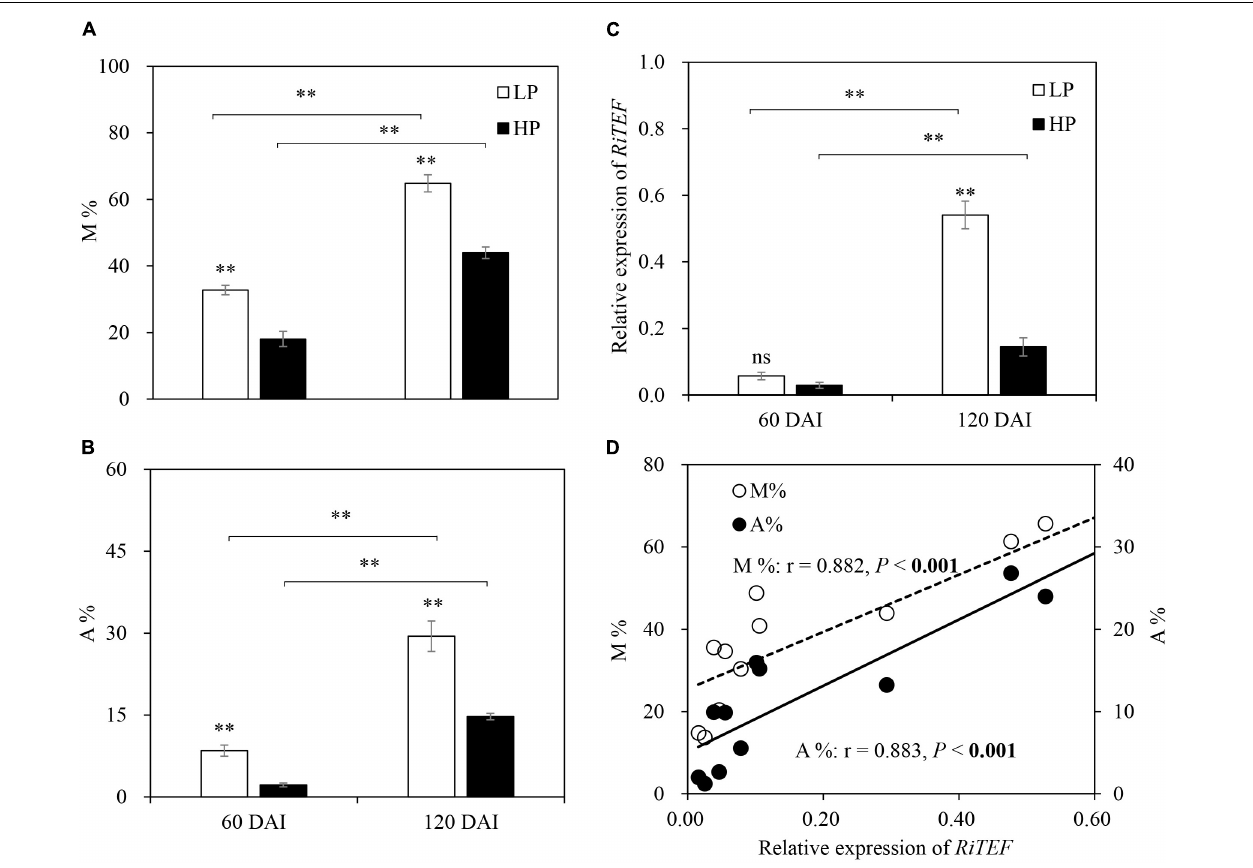
FIGURE 1 | (A) Mycorrhizal colonization (M%), (B) arbuscule abundance (A%), and (C) relative expression of RiTEF as affected by soil P levels 60 and 120 days after inoculation (DAI). LP and HP represent 30 and 170 mg kg − 1 P application, respectively. Data are presented as mean ± standard error (SE, n = 4). Treatment effects were tested by Student’s t -test at the P < 0.05 level. ∗∗ P < 0.01. (D) Relative expression of RiTEF in relation to M and A% across two harvests. Pearson correlation analyses were conducted to check the